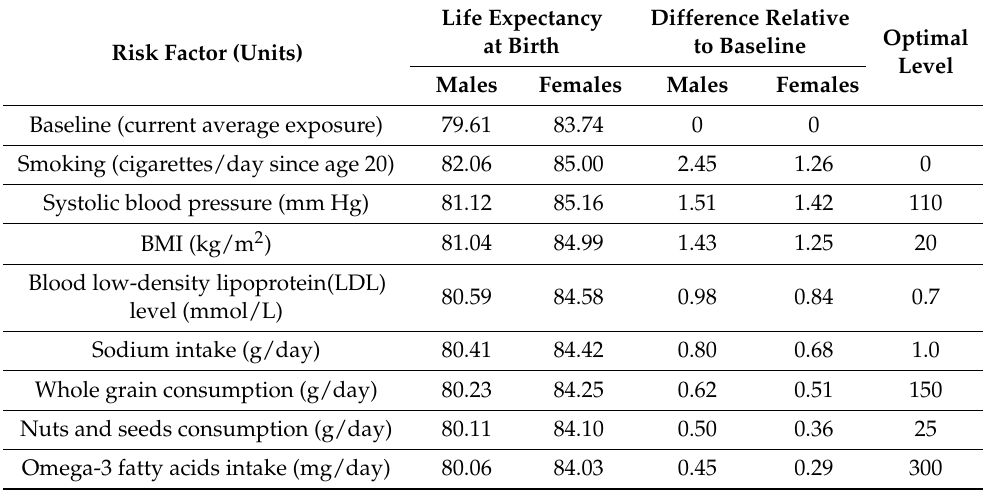
Table 1. Life expectancy at birth (LE0) assuming the optimal level of each factor and difference in LE0 between the optimal and current average exposure for 51 risk factors individually. Life Expectancy Difference Relative at Birth to Baseline Optimal Risk Factor (Units) Level Males Females Males Females Baseline (current average